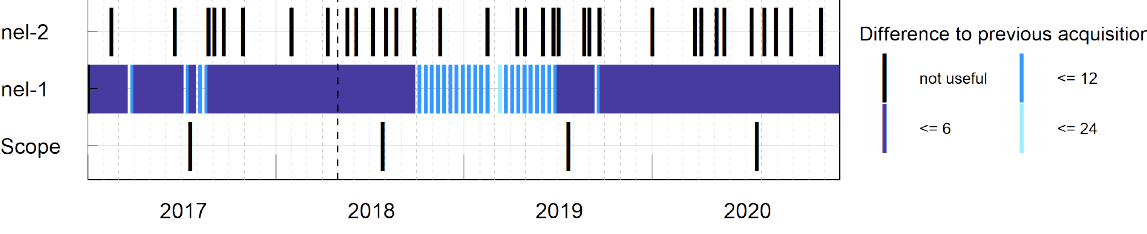
Figure 4. S-2 acquisitions used for hull function interpolation (n = 34), S-1 acquisitions (n = 215) and PlanetScope imagery (n = 4) in the analysis period. The dashed line indicates drought onset (approximately 1 April